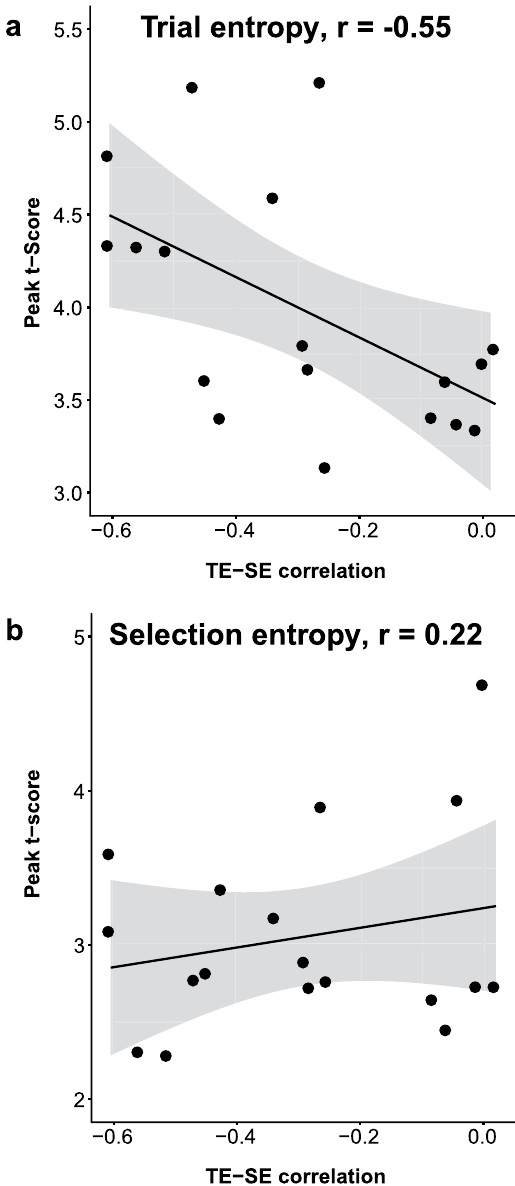
Figure 5. The correlations between MEG peak t-scores for TE ( a ) and SE ( b ) and the TE-SE correlations for individual participants. Best fit linear regression lines and their standard errors are superimposed. There is a significant negative correlation for TE (Pearson’s r = − 0.55, n = 18, p = 0.018) but not for SE (Pearson’s r = 0.22, n = 18, p =